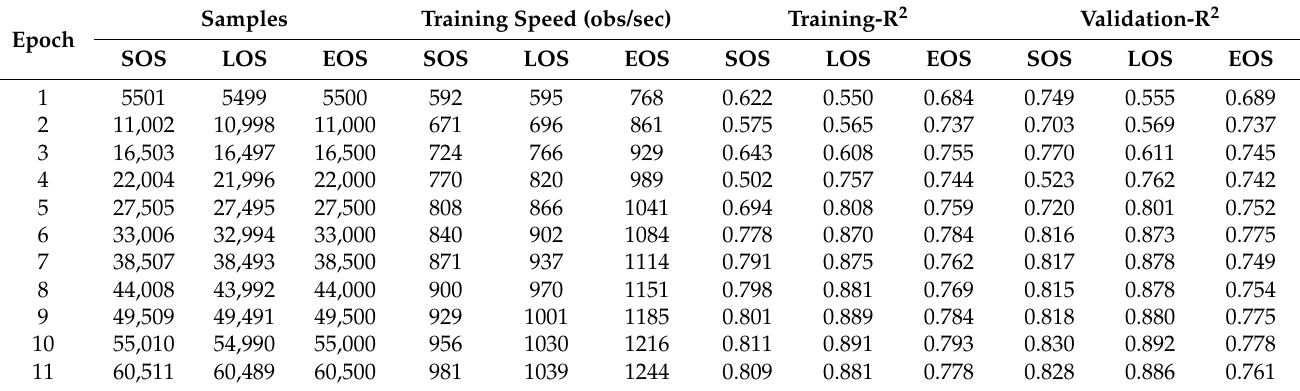
Table 4. Scoring performance of DFNN model at each iteration during the different phenological stage.